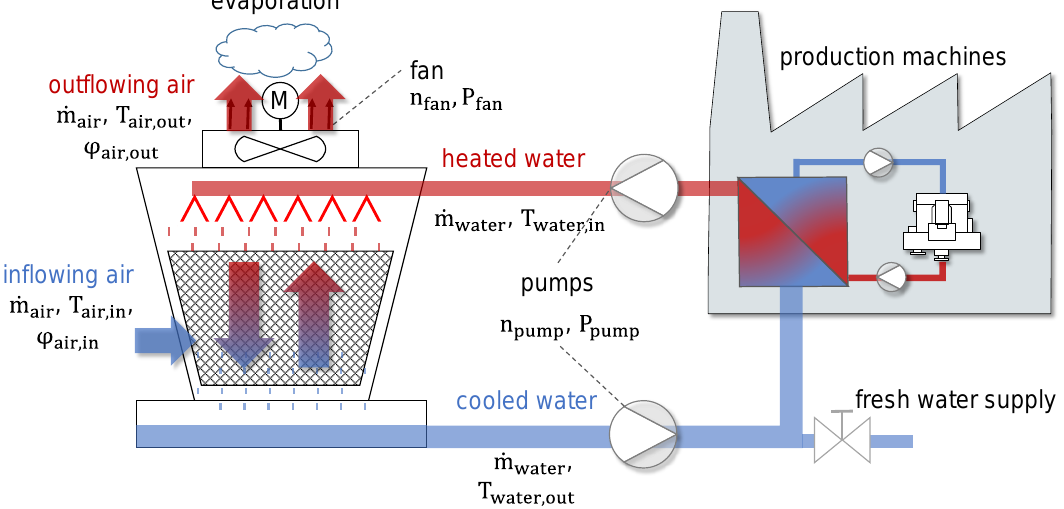
Figure 1. Components and parameters of an industrial cooling tower system based on [25].